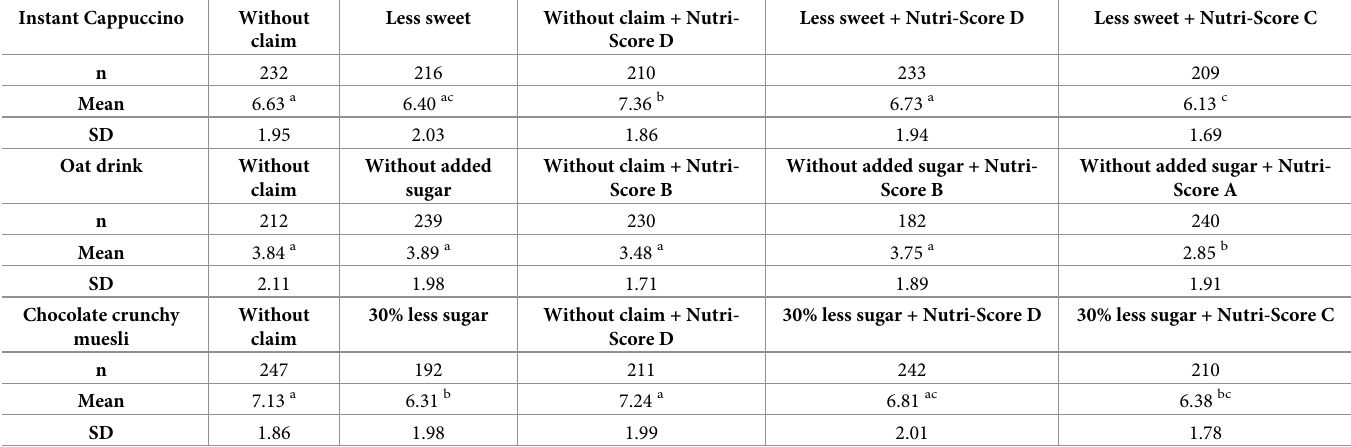
the respective product, while the Nutri-Score C or Nutri-Score D were able to correct the health added sugar) did not increase consumers’ health assessment of the product, while the Nutri- Score A increased the health assessment of the oat drink. Results can be found in Table 4. Table 4. ANOVA of the health evaluation of three products with/without claim and Nutri-Score. Instant Cappuccino